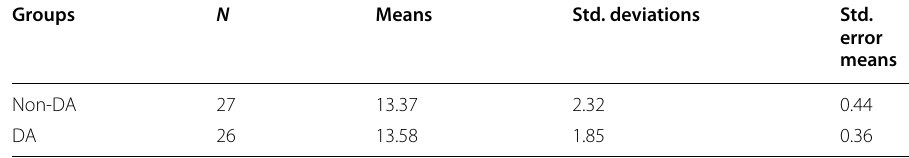
Table 7 Inferential statistics (writing pretest of both groups)